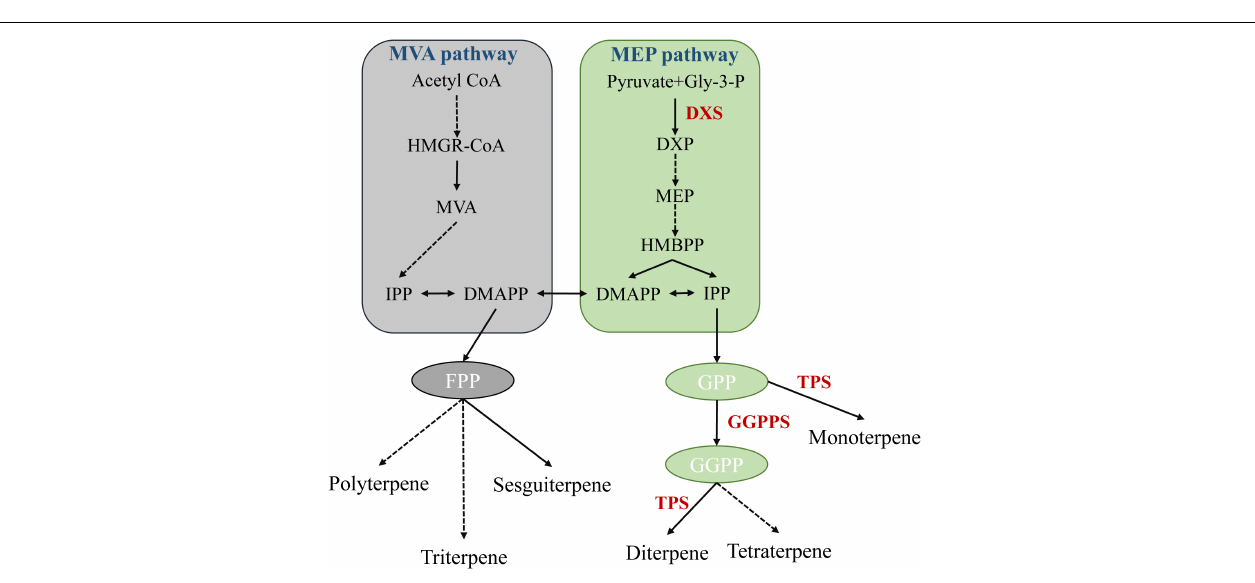
FIGURE 5 | Schematic diagram of MEP and MVA pathways (Zhang et al., 2021). Each solid arrow represents a biosynthetic reaction step, and dashed arrows represent multiple-step reactions. HMGR: 3-hydroxy-3-methylglutary-CoA reductase, MVA: mevalonate, DMAPP: dimethylallyl pyrophosphate, IPP: